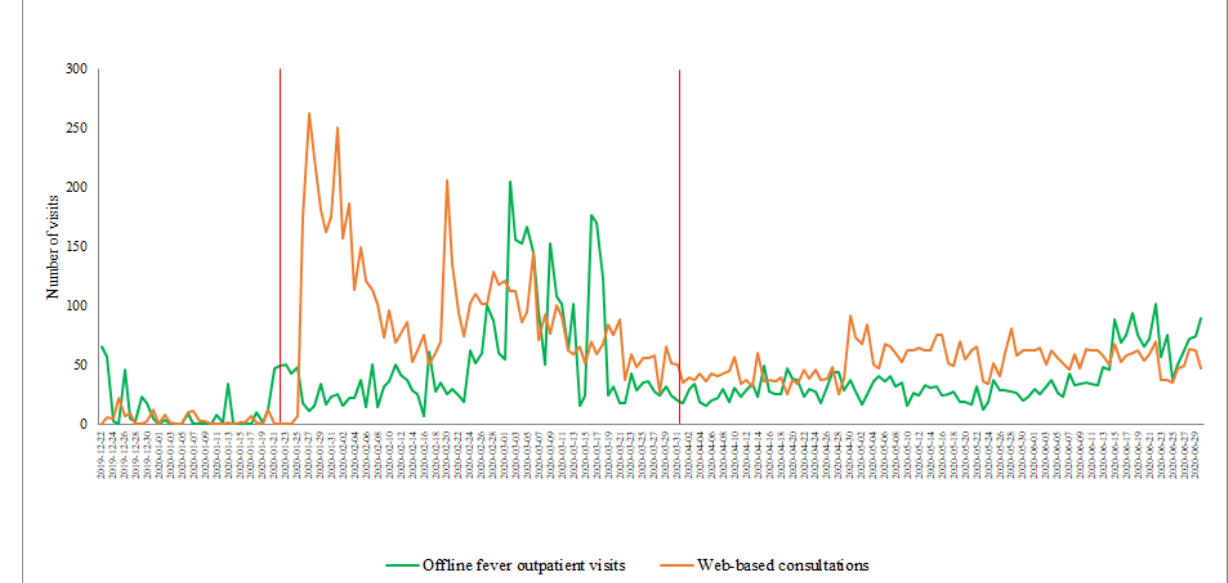
Figure 6. The trends of fever clinic visits and web-based consultation visits from December 22, 2019, to June 30, 2020. The red lines denote the start of the controlled period and the end of the postepidemic